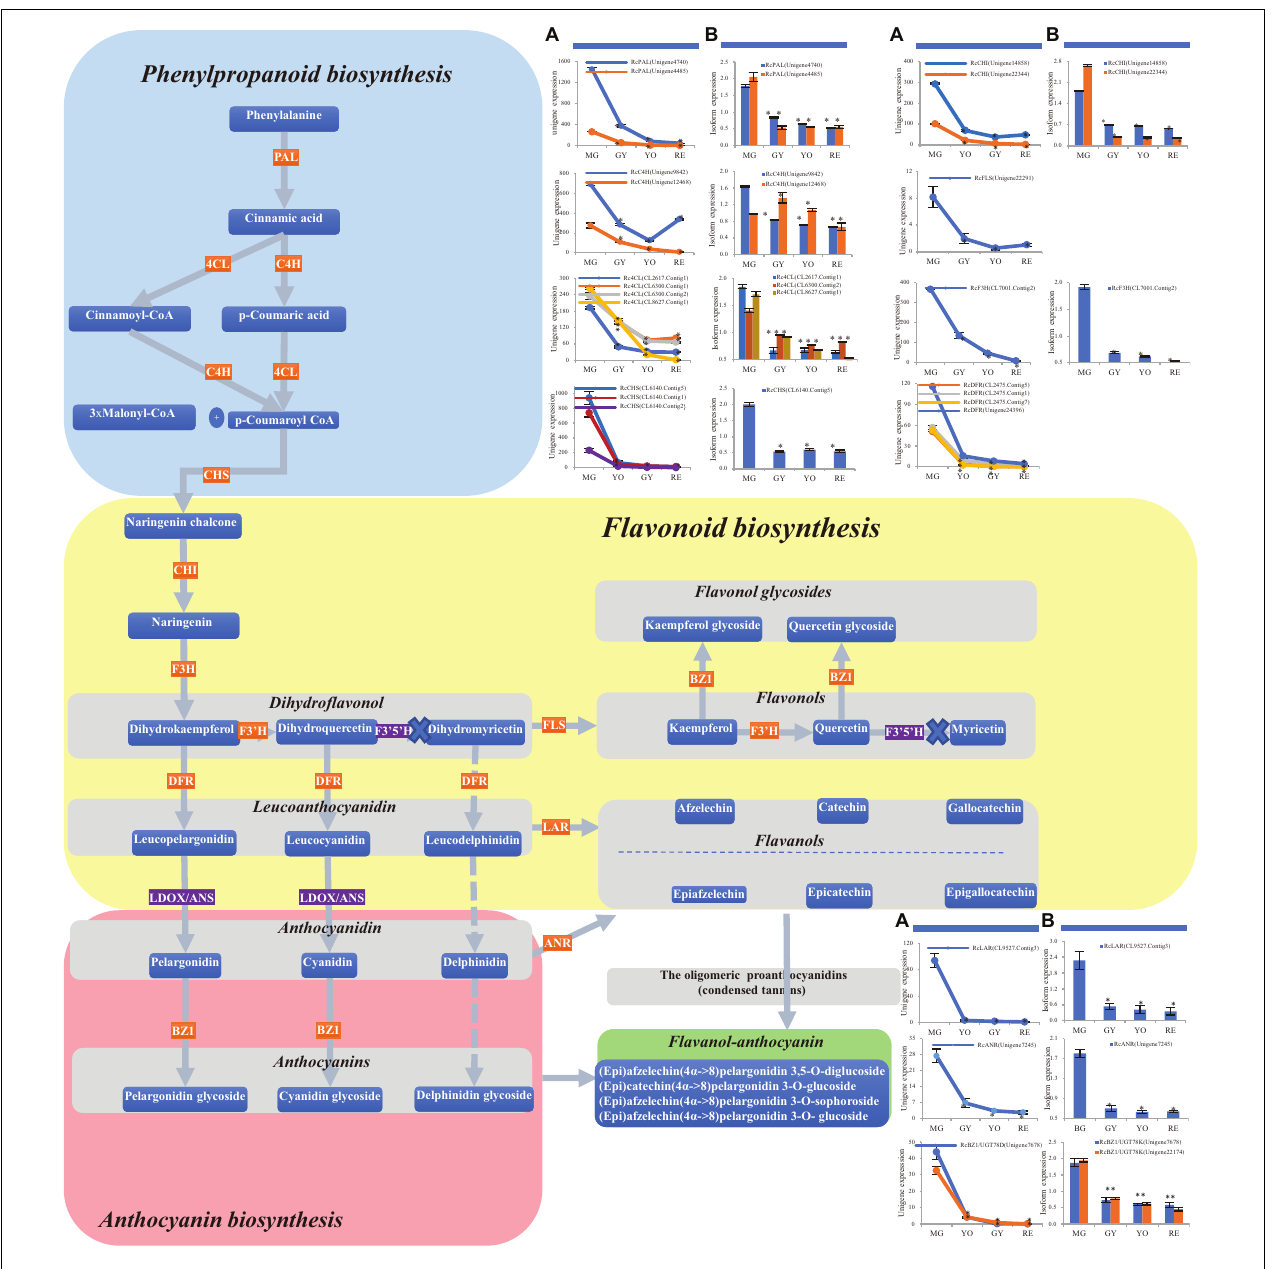
FIGURE 4 | Changes in phenylpropanoid, flavonoid and anthocyanin biosynthesis during four maturation phases in R. chingii . (A) The change of mRNA unigene expression, (B) the change of protein expression. RcANS, shown in the purple rectangle, was expressed at a low gene level while RcF3 (cid:48) 5 (cid:48) H was not detected at the gene/protein level. No expression of RcF3 (cid:48) 5 (cid:48) H, shown in the purple rectangle, blocked biosynthesis of the dihydromyricetin, leucodelphinidin, (epi) gallocatechin and their corresponding glycosides. Flavanols and anthocyanins were condensed into flavanol-anthocyanins, shown in the green